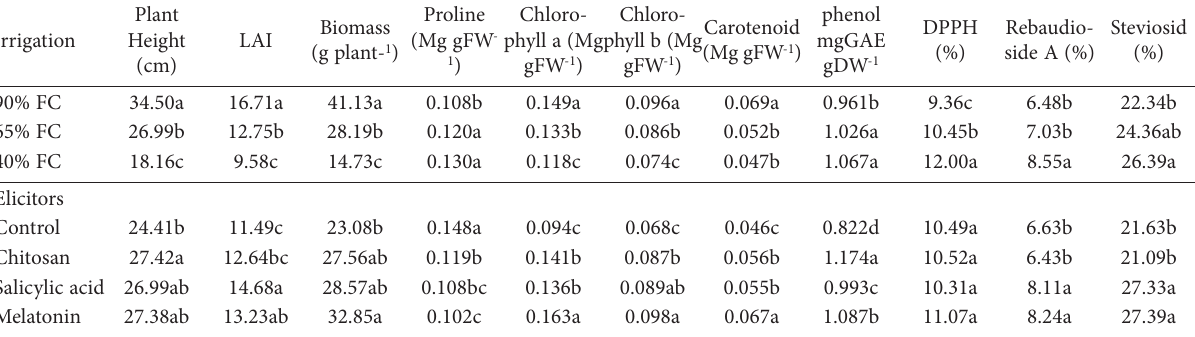
Table 3. Mean comparison of main effects of irrigation and spraying elicitors treatments of on studied traits in Stevia ( Stevia rebaudiana Bertoni ).